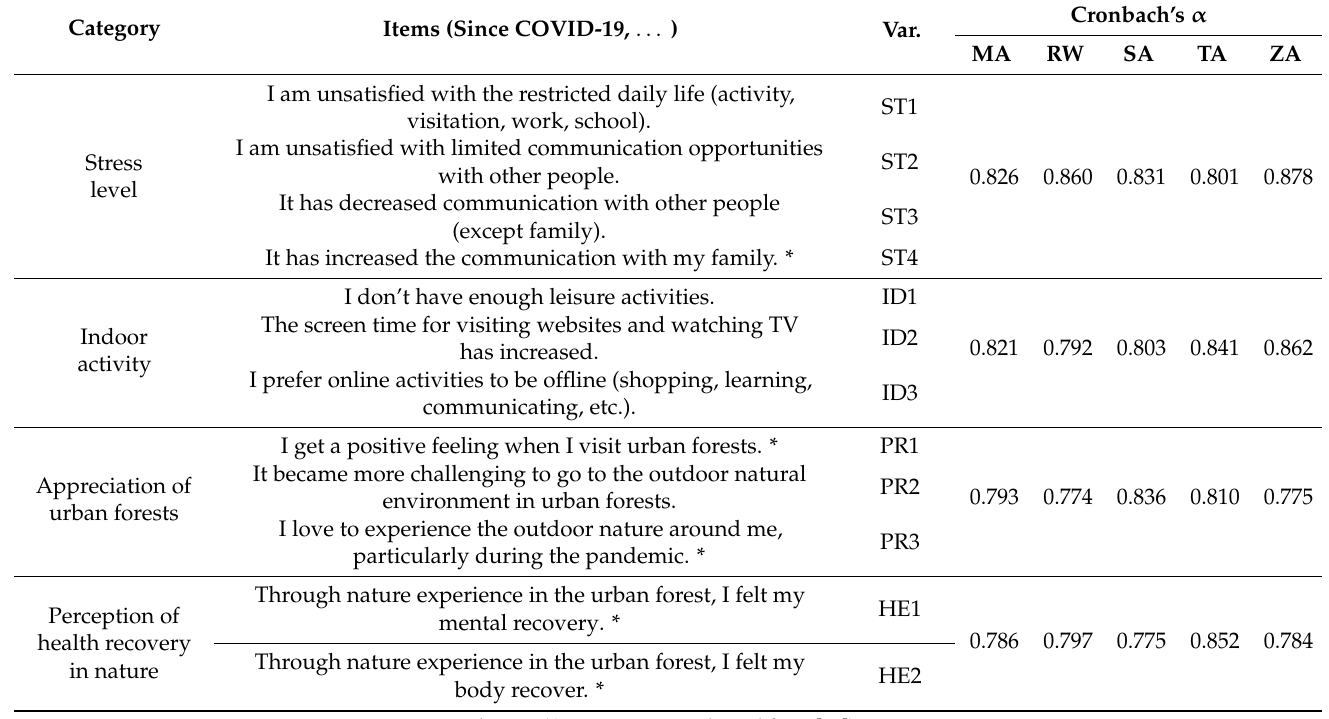
Table 2. Interview questionnaire’s reliability by